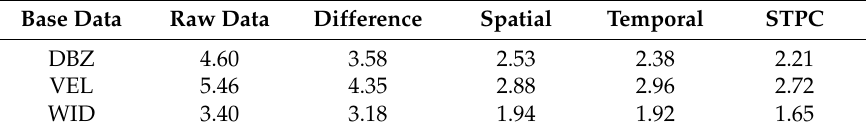
Table 3. Entropy of raw elevation cut and residual using different prediction mode.